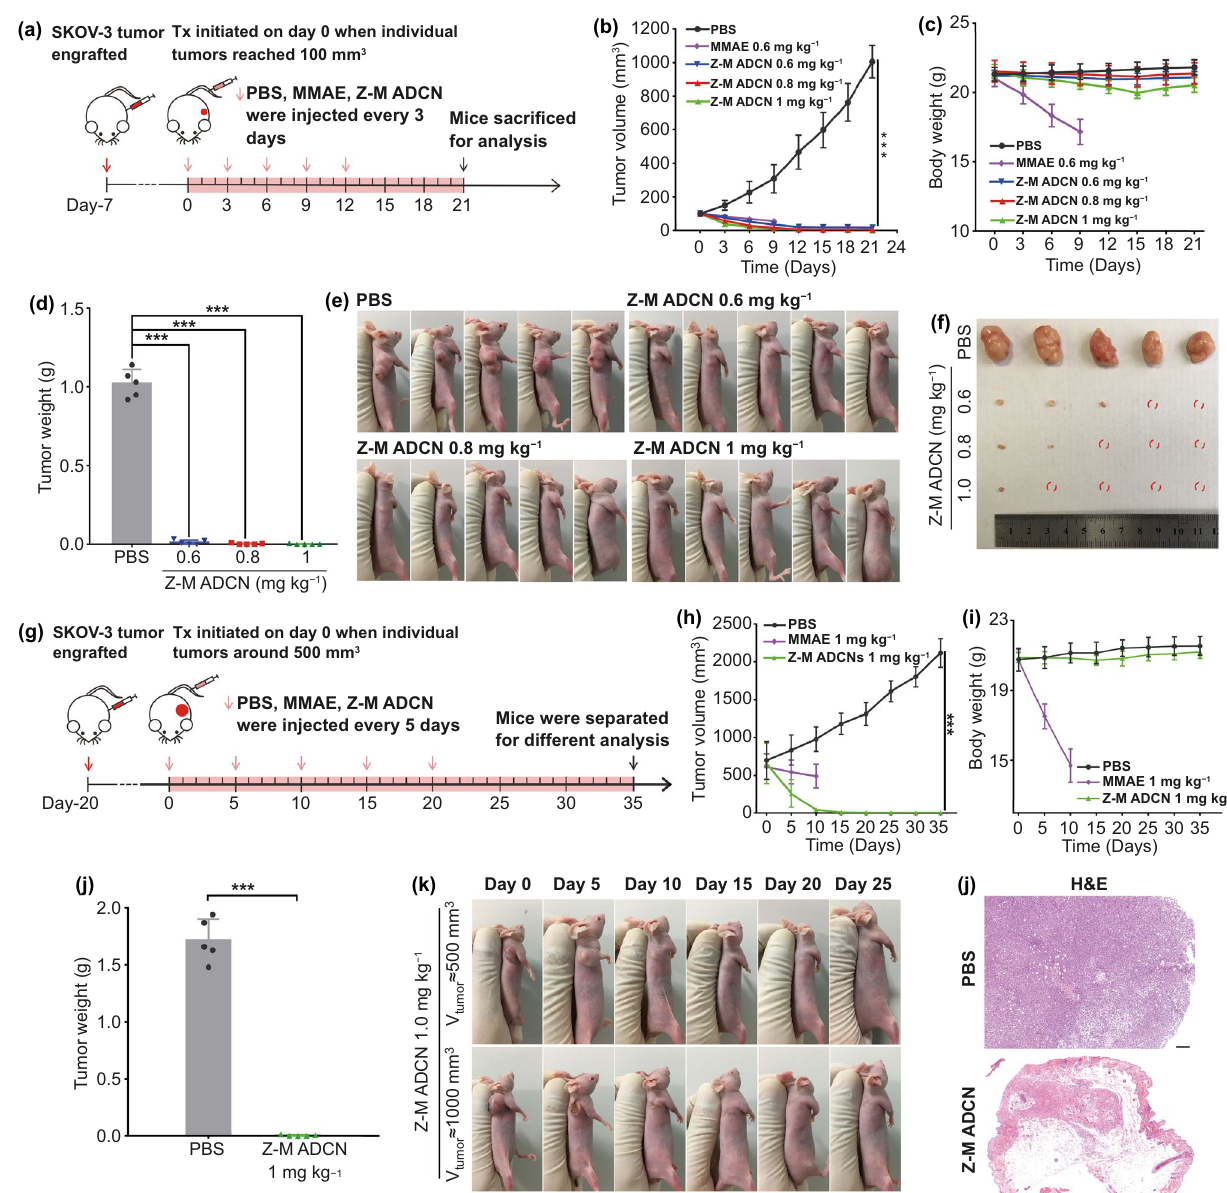
Fig. 5 Antitumor efficacy of Z-M ADCN against small and large SKOV-3 tumor models. The initial volumes of tumors in these trials were about 100 mm 3 ( a–f ) and 500 mm 3 ( g–l ). a Schematic illustrating of the small tumor experiment. b Tumor growth curves of each group after the i.v. injection of PBS, MMAE (0.6 mg kg −1 ), and Z-M ADCN (MMAE-equiv. dose, 0.6 mg kg −1 , 0.8 mg kg −1 , and 1 mg kg −1 , respectively) once every three days for five times. c Body weight changes during the treatment. d The average tumor weight of each group after total experi- ment. The residual tumors were collected on day 21. e Images of SKOV-3 xenograft-bearing mice after different treatments at endpoint of the experiment. f Representative images of tumors harvest on day 21 after the initial treatment (the red dashed cycles indicate no tumor). g Sche- matic illustrating of the large tumor experiment. h Tumor growth curves of each group after the i.v. injection of PBS, MMAE (1 mg kg −1 ), Z-M ADCN (MMAE-equiv. dose, 1 mg kg −1 ) once every five days for five times. i Body weight changes during the treatment. j The average tumor weight of each group after total experiment. The residual tumors were resected on day 35. k Images of two representative mice (volumes of tumors were around 500 and 1000 mm 3 , respectively.) with the treatment of Z-M ADCN (MMAE-equiv. dose, 1 mg kg −1 ) during the 25-day evaluation period. l H&E analysis of tumor tissues which were collected on day 35. Scale bars: 200 μm. Data are presented as the mean ± s.d. ( n = 5 mice). Statistical significance: *P < 0.05, **P < 0.01, ***P <